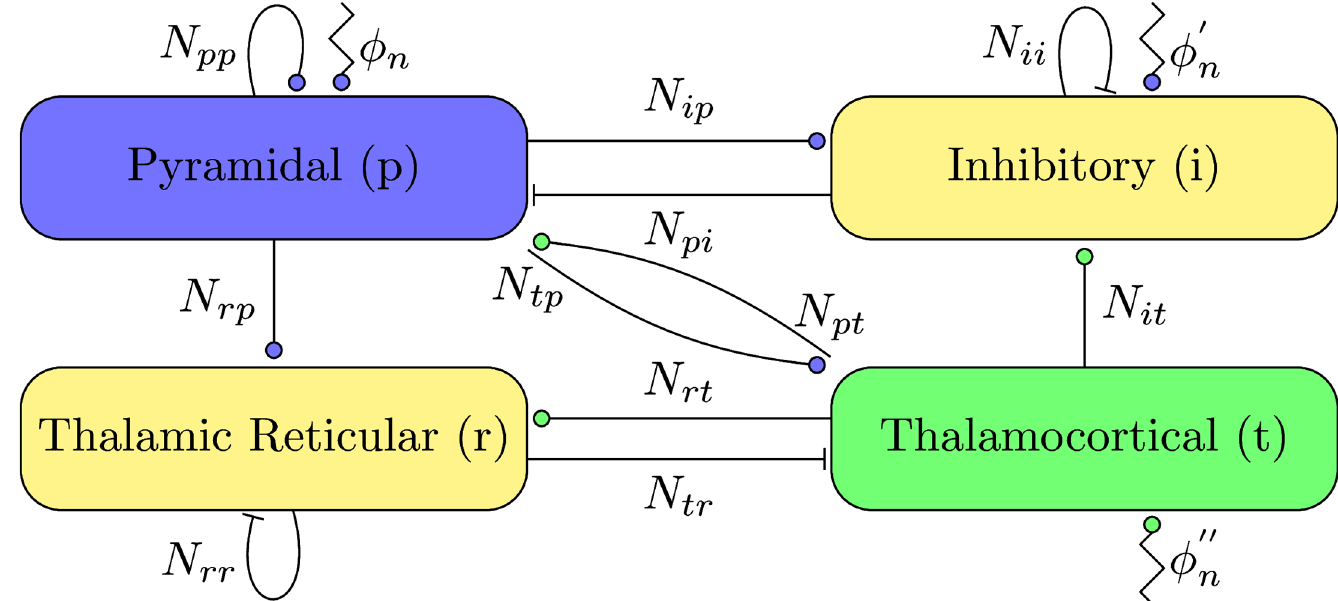
Fig 1. Connectivity of the thalamocortical model. Excitatory synapses are depicted by filled circles, inhibitory synapses by bars. Independent background noise entering the different populations is denoted by ϕ n , (cid:2) 0 background noise (cid:2) 00 of the thalamic relay n